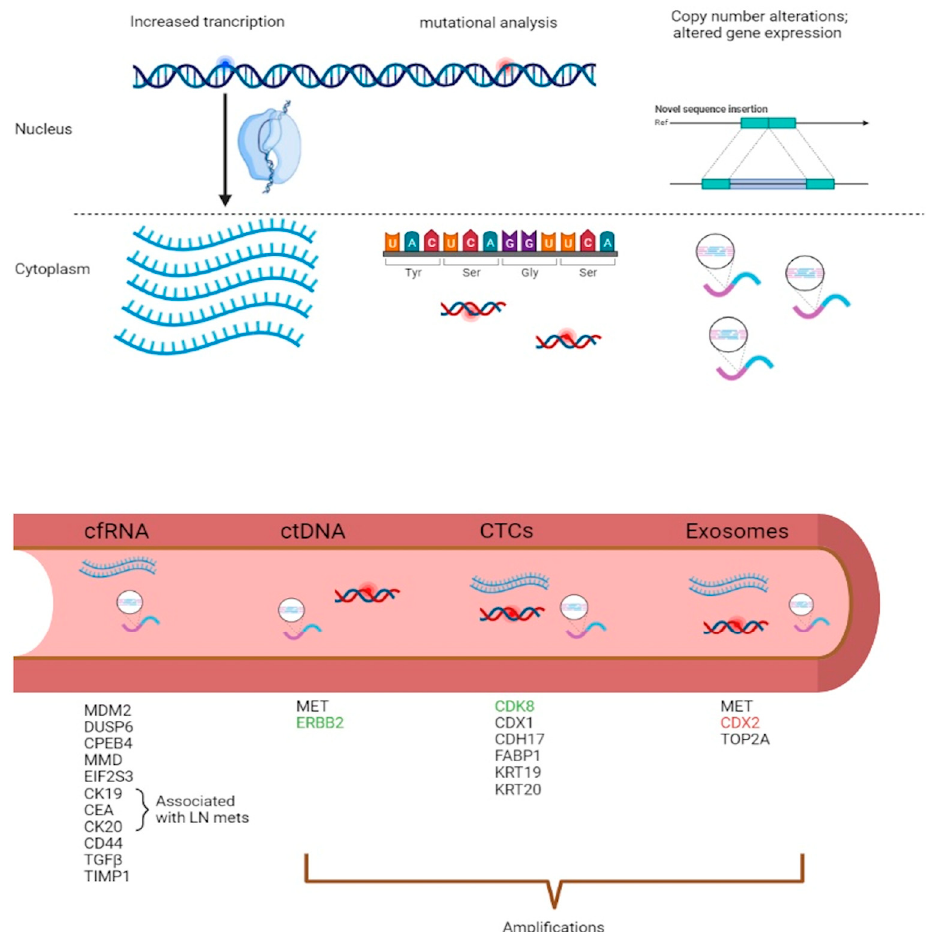
Figure 2. The most common sources of genetic material found in liquid biopsy sources. A list of genetic aberrations (gene amplifications and expression) is summarized in the figure below. Such data was collated from different literature sources. The green coded genes show CNVs associated with the carcinoma to metastatic progression, and the red coded gene shows CNVs associated with the adenoma to carcinoma progression. Table 3. Advantages and Disadvantages of the different liquid biopsy sources in relation to CNVs.